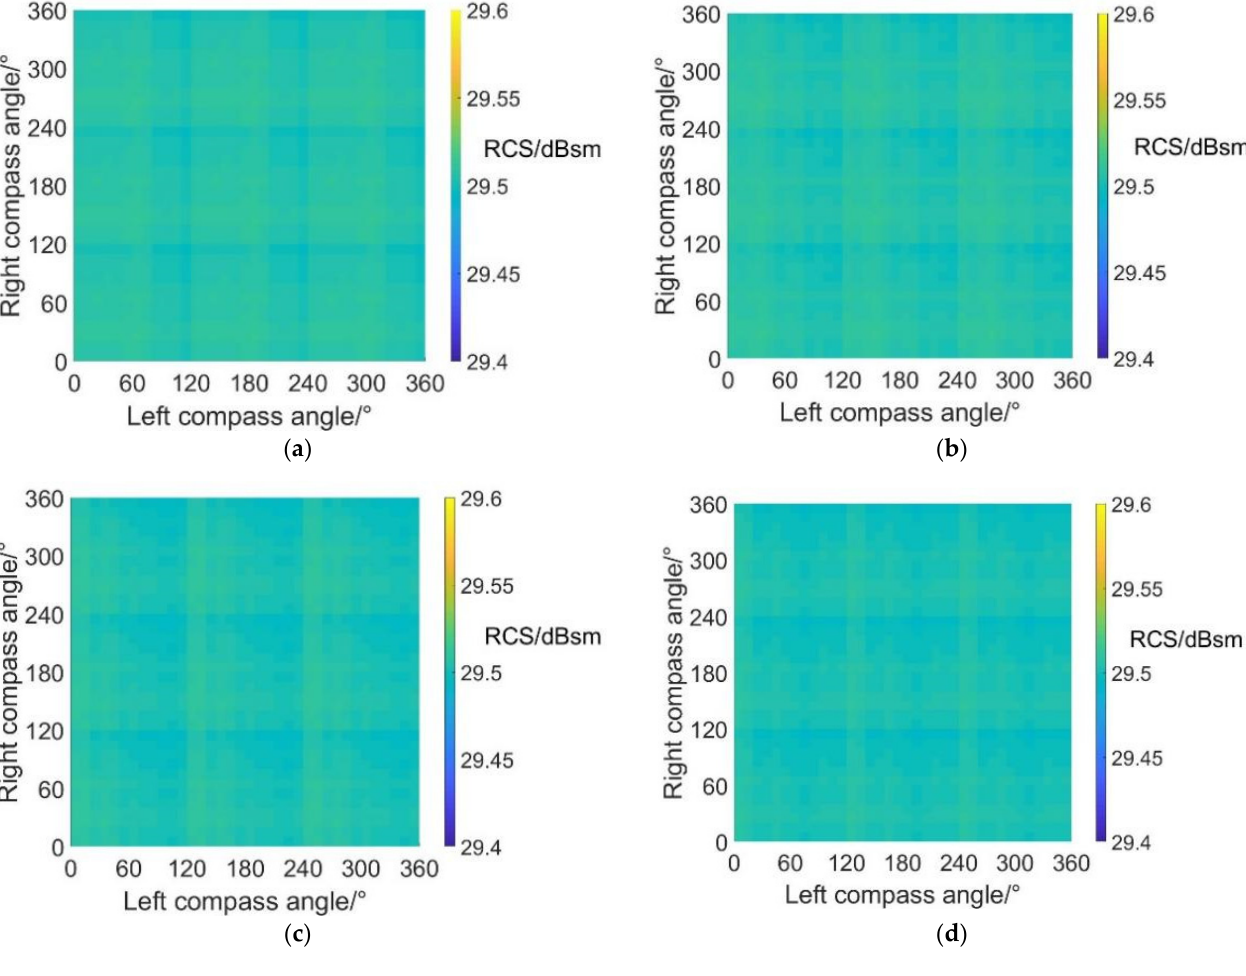
Figure 20. Carpet diagrams of average RCS in fixed-wing mode at an azimuth angle = 90 ◦ with scissors angle difference = ( a ) 0 ◦ , ( b ) 30 ◦ , ( c ) 60 ◦ , ( d ) 90 ◦ . The maximum and minimum average RCS values in fixed-wing mode at an azimuth angle = 180 ◦ are listed in Table 16. By CSM phase modulation, the average RCS in fixed- wing mode at an azimuth angle = 180 ◦ can be reduced by 1.8 dBsm at most. Table 16. Highest and lowest average RCS values at an azimuth angle = 180 ◦ in fixed-wing mode. Scissors Angle Difference/